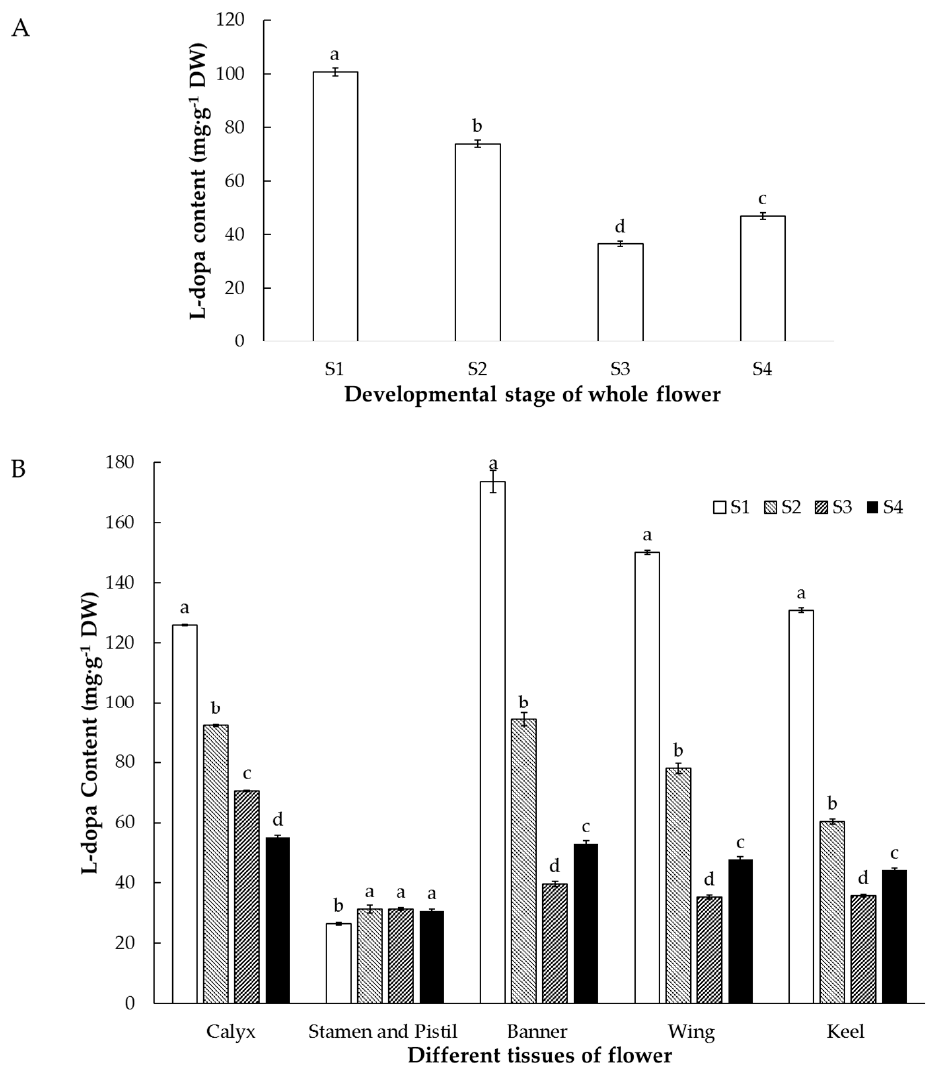
Figure 4. Changes in L-dopa content in ( A ) whole flowers at different developmental stages; and ( B ) different flower tissues. S1 to S4 indicate flower bud, unopened flower, fully opened flower, and senescent flower, respectively. DW, dry weight. Different letters above bars indicate significant differences at p < 0.05 (Tukey’s HSD test).